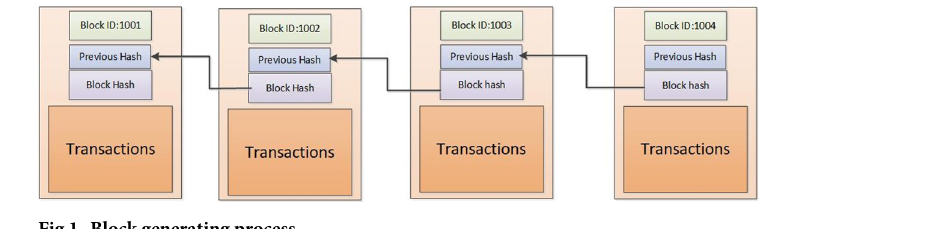
Fig 1. Block generating